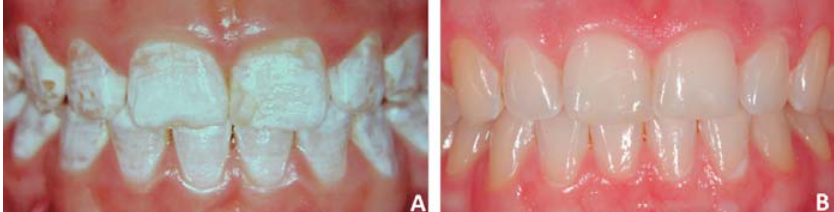
Figure 2- A: A 12-year-old girl had idiopathic white enamel demineralization of both the maxillary and mandibular teeth; B: The teeth are shown eleven years after the enamel microabrasion. The worn mesial and incisal surfaces of the maxillary central incisors were reconstructed with composite resin, shades A1 and A2